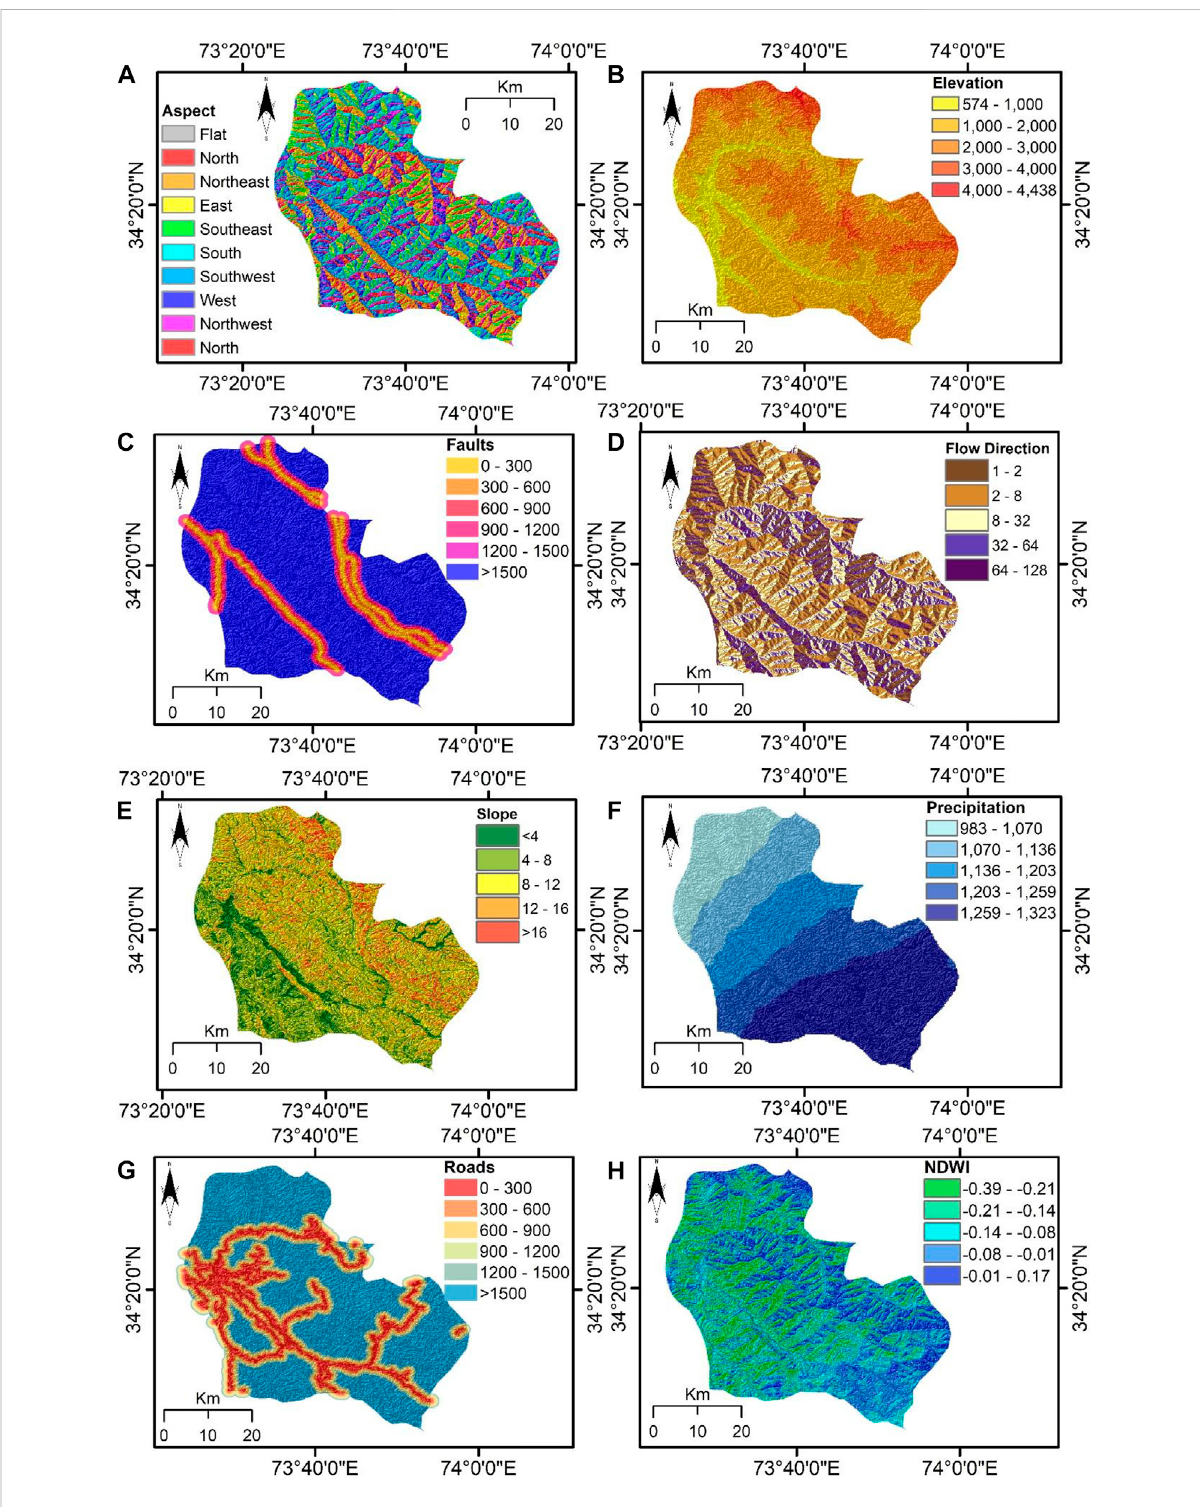
FIGURE 3 Input derived datasets: (A) aspects, (B) elevation, (C) faults, (D) fl ow direction, (E) slope, (F) precipitation, (G) roads, (H) NDWI, (I) waterways, (J) earthquake, (K) lithology, (L) NDVI, (M) plan curvature, (N) pro fi le curvature, (O)